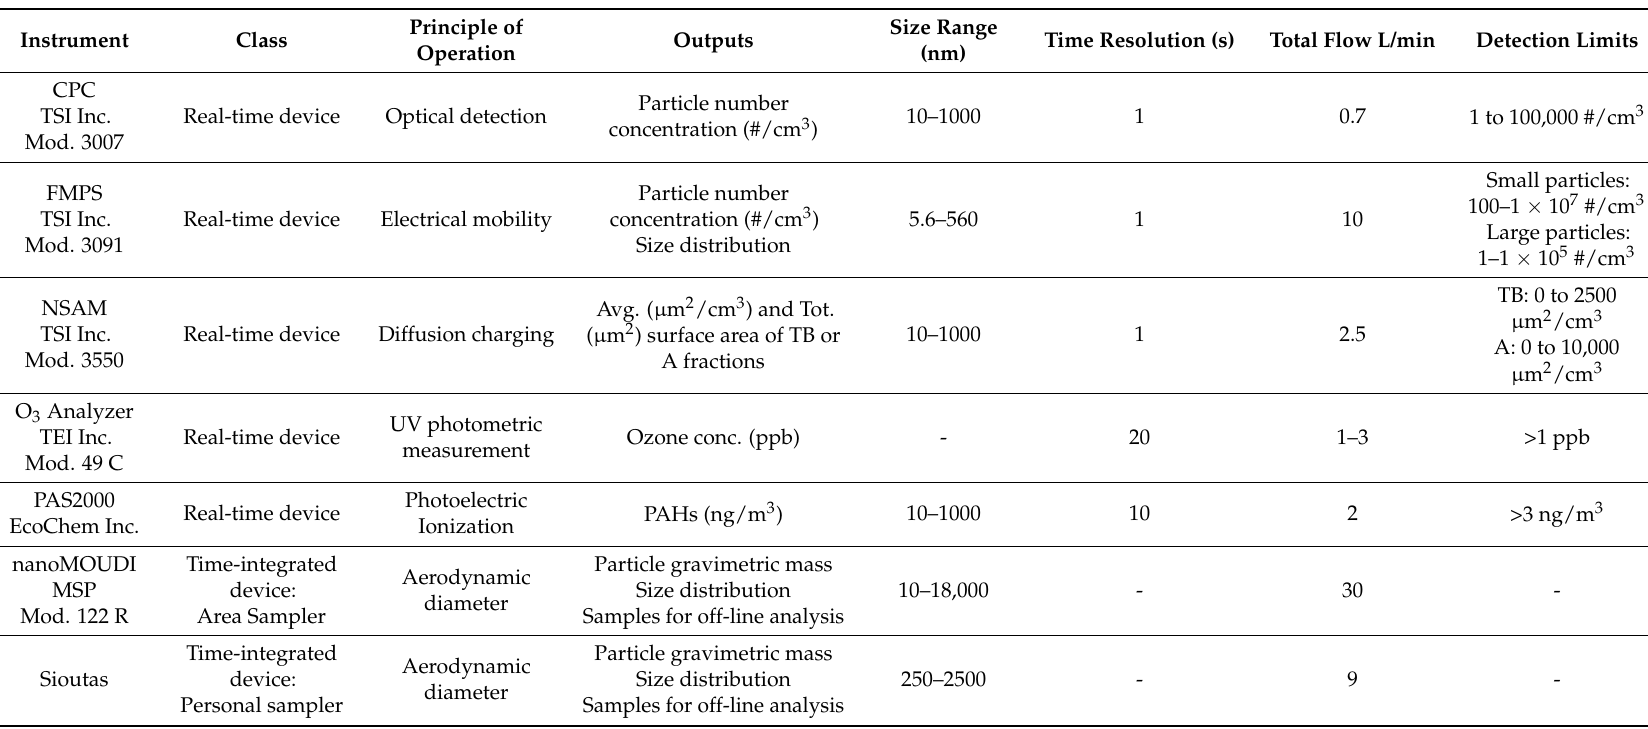
Table 2. Main specifications of real-time and time-integrated instruments employed in the intensive measurement campaign. UV: ultraviolet; PAHs: polycyclic aromatic hydrocarbons; TB: tracheobronchial; A: